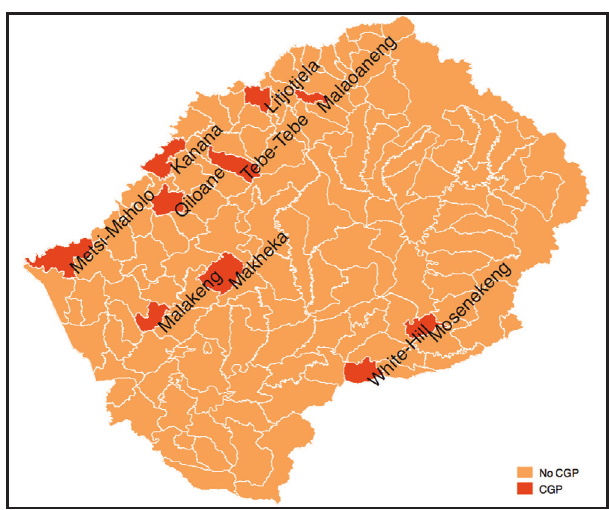
Figure 1 Community Councils covered by Child Grant Programme (CGP) in Phase 1—Round